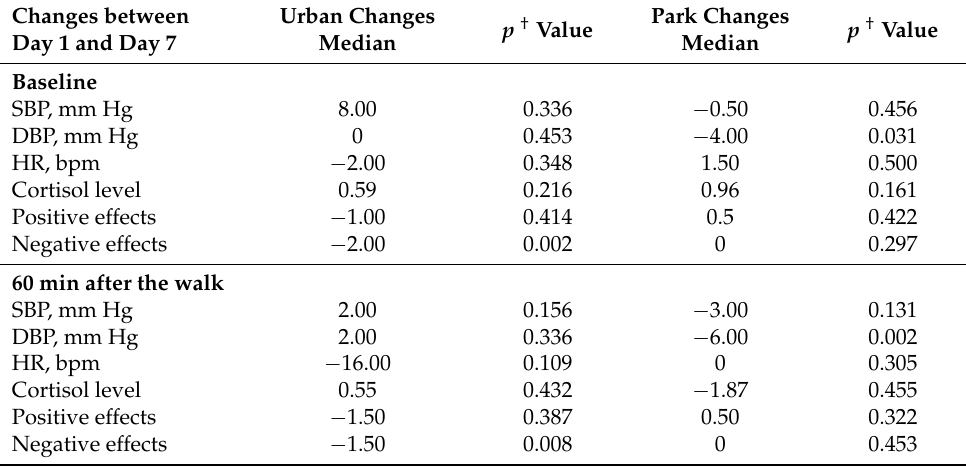
Table 4. Changes in hemodynamic parameters, cortisol, and mood between the first and seventh days exposure in different